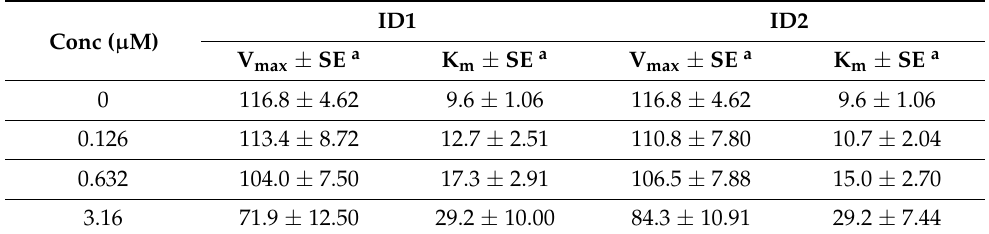
Table 3. Derived K m and V max Average Values +/ − Standard Error (SE) of nitrocefin and OXA-48 Enzyme respectively Varying the Concentration of OXA-48 Inhibitors ID1 and ID2 .